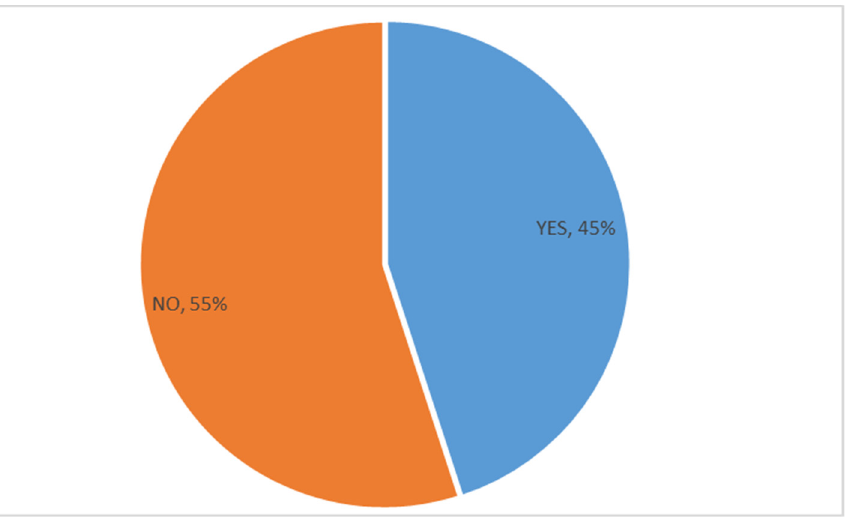
Figure 7. “Does regulatory compliance or a regulated environment/culture at as a barrier to continuous improvement programs in your